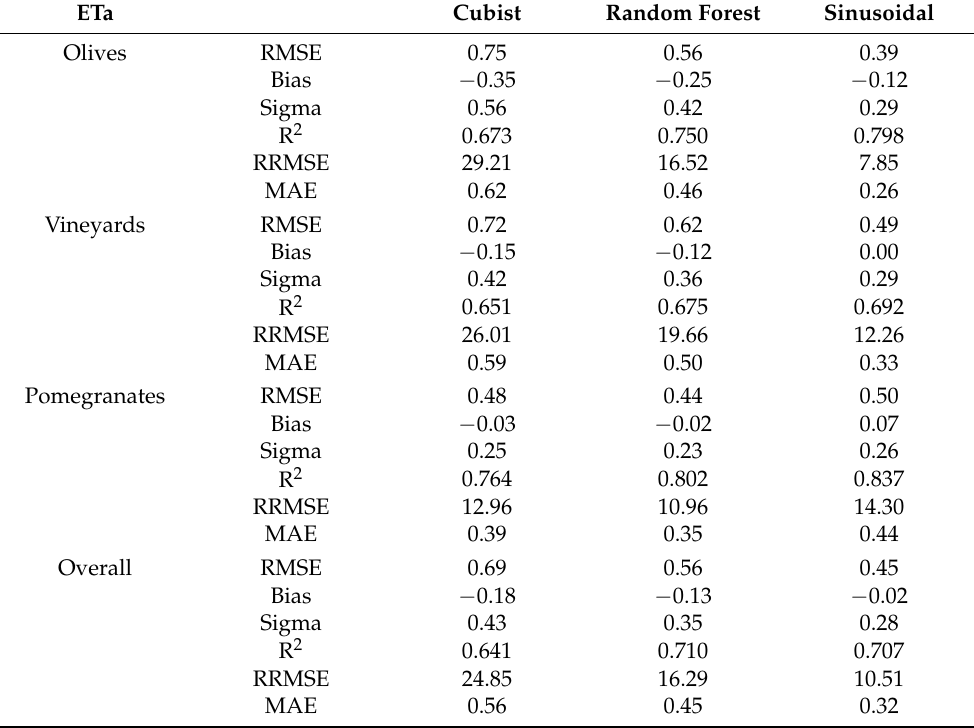
Table 3. Model performance statistics of ETa estimated using cubist, random forest, and sinusoidal models compared with the ETc over olives, vineyards, and pomegranates orchards. ETa Cubist Random Forest